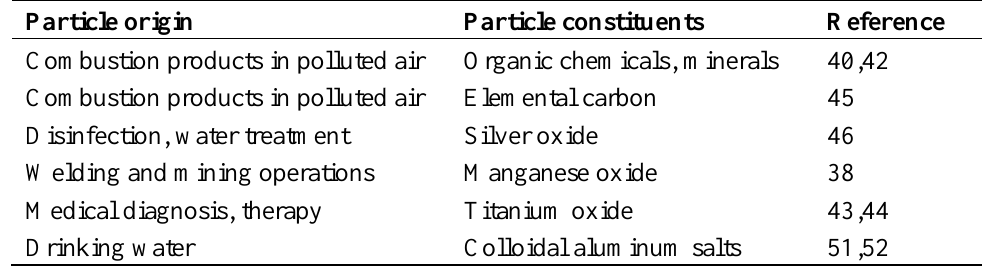
Table 2. Particles and colloids of exogenous origin causing an inflammatory response within the